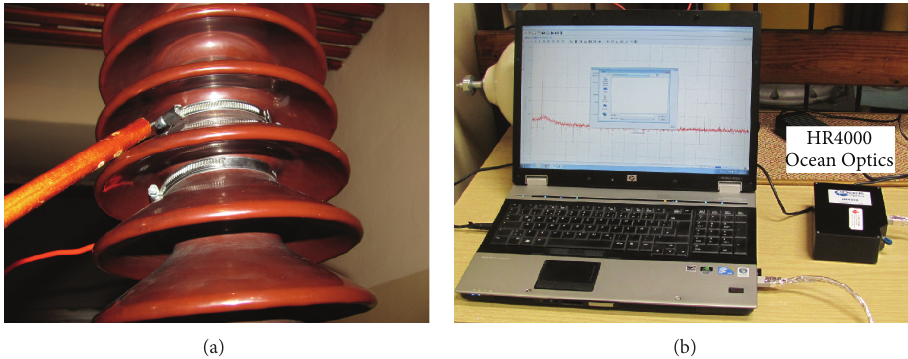
Figure 1: (a) The long rod insulator, type LS, and (b) the spectrophotometer applied in the study.